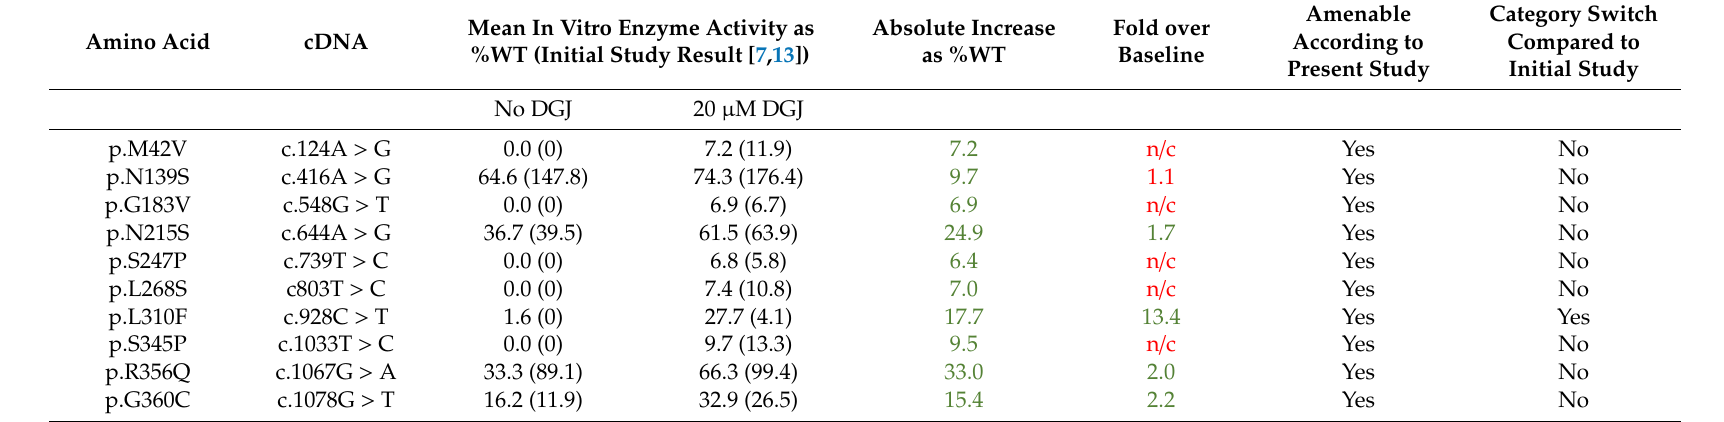
Table A1. Reexamination of selected GLA variants.